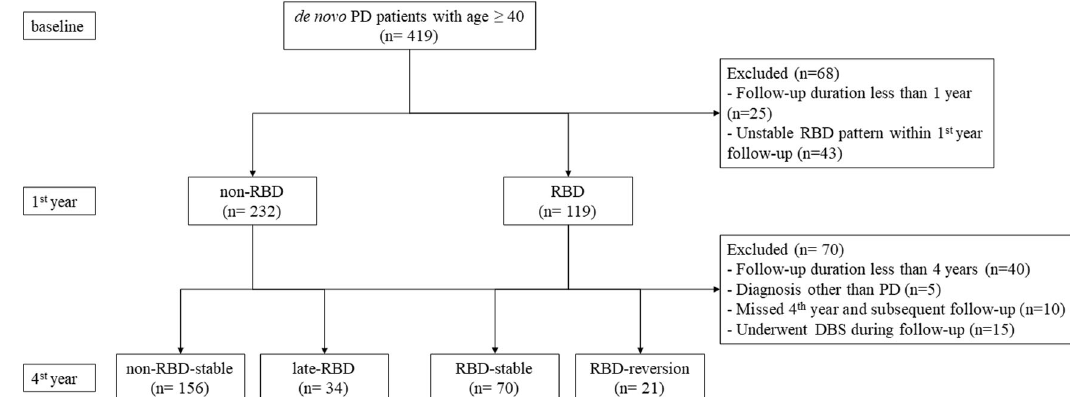
Fig. 1 Flowchart of the study participants. DBS deep brain stimulation, PD Parkinson ’ s disease, RBD REM sleep behavior